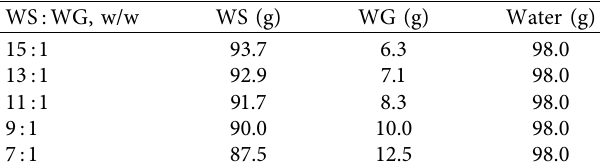
Table 1: Formula of the batter (WS and WG represent wheat starch and wheat gluten,